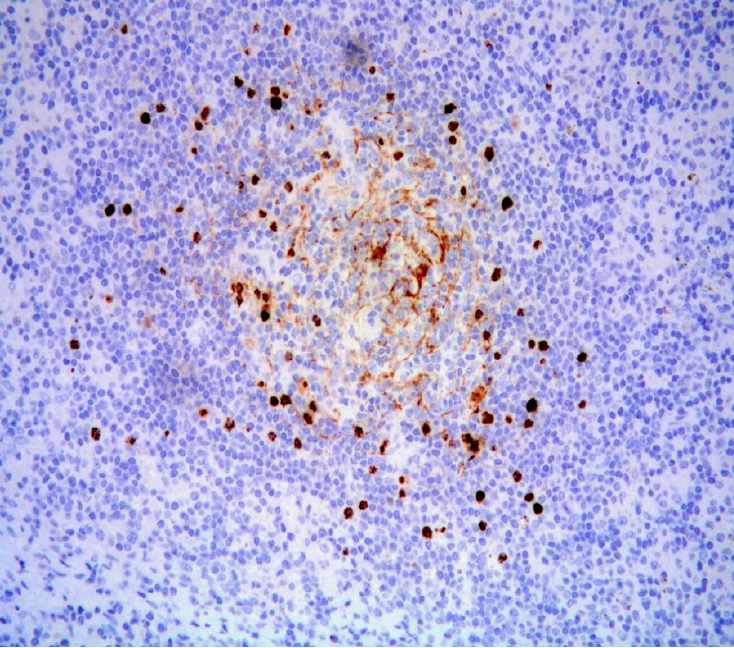
Figure 4. Scattered cells positive for HHV8 immunostaining (magnification 200×). These findings were consistent with HHV8-positive multicentric Castleman disease (MCD) of mixed type associated with in situ mantle cell neoplasia (isMCN). The transloca- tion t(11;14)(q13;q32) characteristic of mantle cell lymphoma (MCL) and the monoclonal IGH gene rearrangement were identified by fluorescence in situ hybridization (FISH) anal- ysis and molecular study, respectively. HHV8 DNA (71 copies/mL) was identified by polymerase chain reaction (PCR) on the plasma